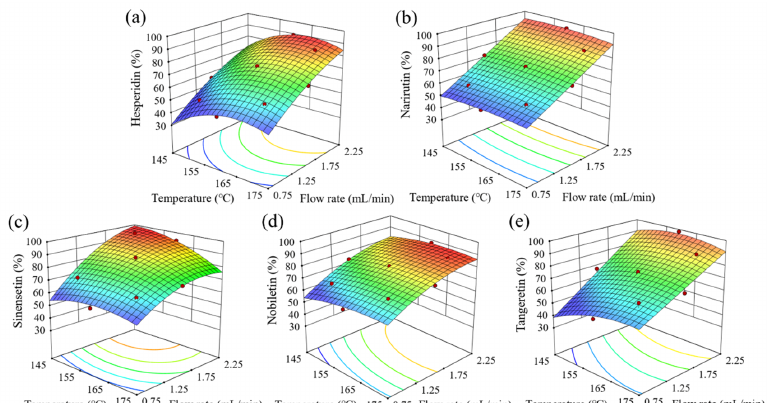
Figure 2. Response surface plots indicating the effects of extraction temperature and flow rate on flavonoid yields: ( a ) hesperidin, ( b ) narirutin, ( c ) sinensetin, ( d ) nobiletin, and ( e )